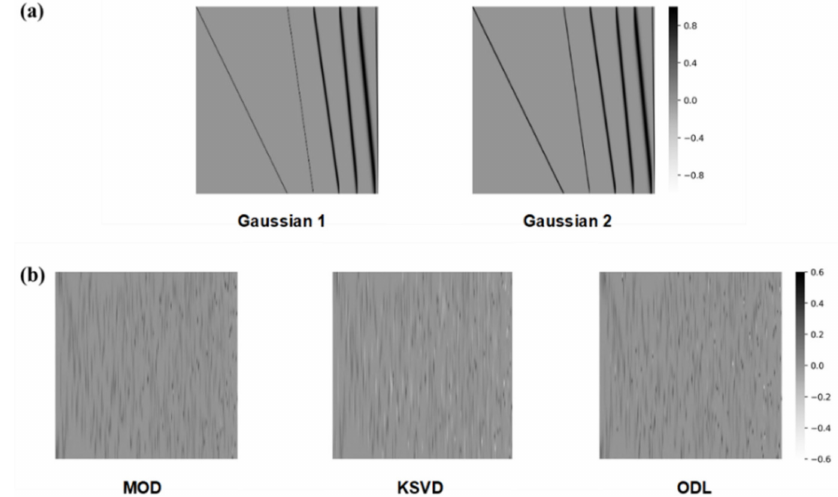
Figure 5. Heatmap images of sparsifying bases that were used in simulated experiments: ( a ) Gaussian line shape matrices, ( b ) the learned dictionaries which are from the Gaussian training